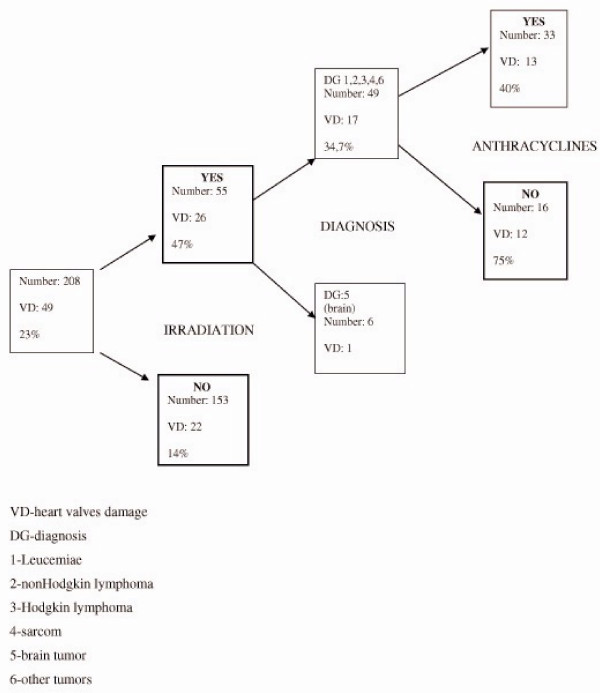
Clasification tree for risk of heart valve disease after treatment of childhood cancer.